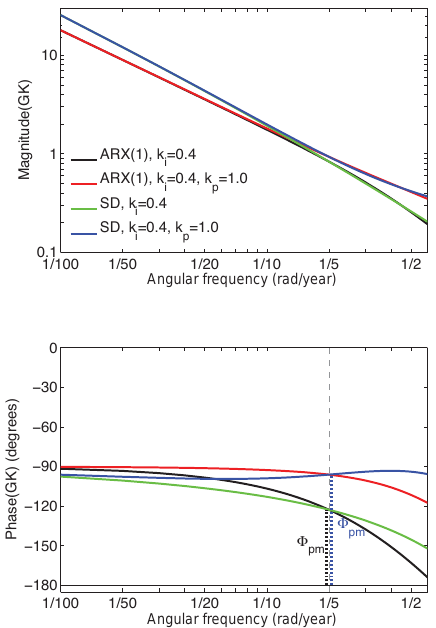
Figure 5. As in Fig. 4 but for the loop transfer function G ( s ) K ( s ) for values of control gains k i and k p used in the 2 × 2 case. Plots are shown for the first-order linear model (ARX(1)) and the semi- infinite diffusion model (SD). Grey dashed lines indicate a loop crossover frequency of ω gc = 0.2, corresponding to the frequency where || GK ||= 1. (cid:56) pm denotes the phase margin (Sect. 3.3; the distance between the curves and a phase lag of 180 ◦ ) for two cases with and without proportional gain k p . Pure integral gain adds 90 ◦ of phase lag, which can be partially compensated for by adding pro- portional